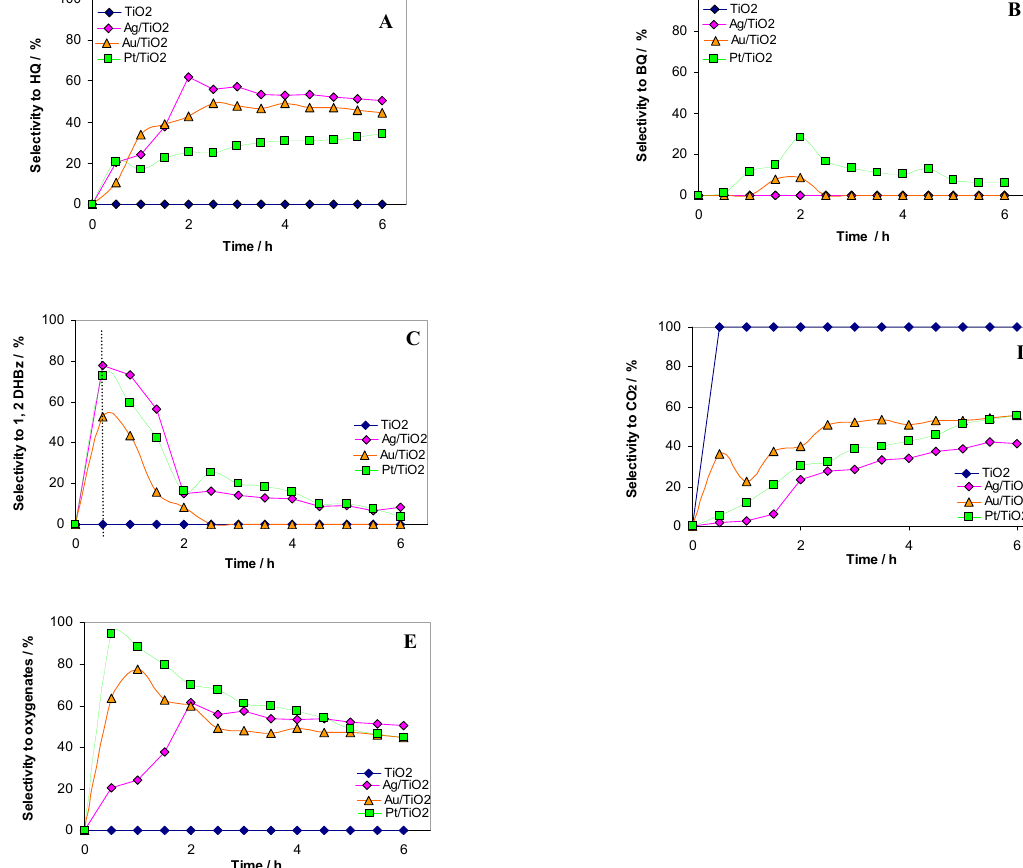
Figure 4. Time course of selectivity for phenol photocatalytic oxidative conversion to HQ ( A ), BQ ( B ), 1,2 DHBz ( C ), CO 2 ( D ) as well as overal selectivity to oxygenates ( E ) over bare and metal-modified TiO 2 exposed to simulated solar